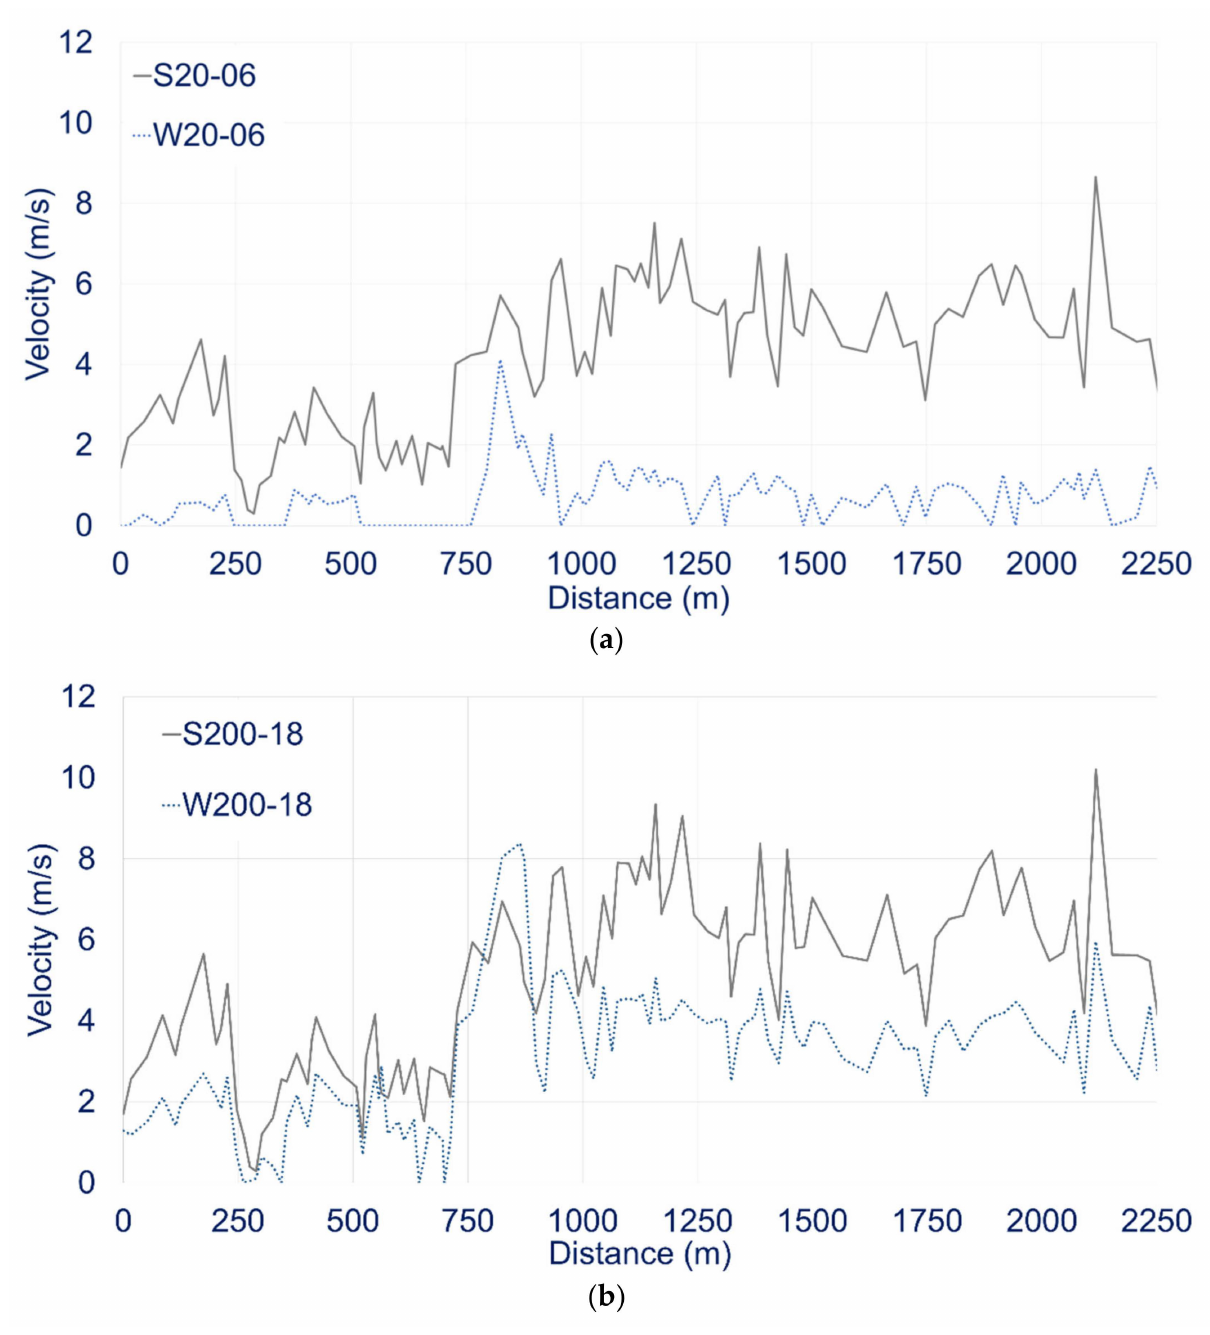
Figure 8. Maximum water velocity along Koropouli Street for 4 indicative scenarios: ( a ) Scenarios S20-06 and W20-06 for T = 20 y and t = 6 h. ( b ) Scenarios S200-06 and W200-06 for T = 200 y and t = 18